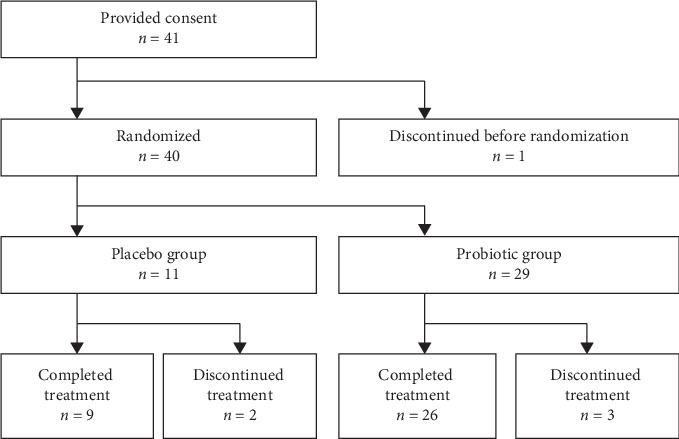
Patient disposition.